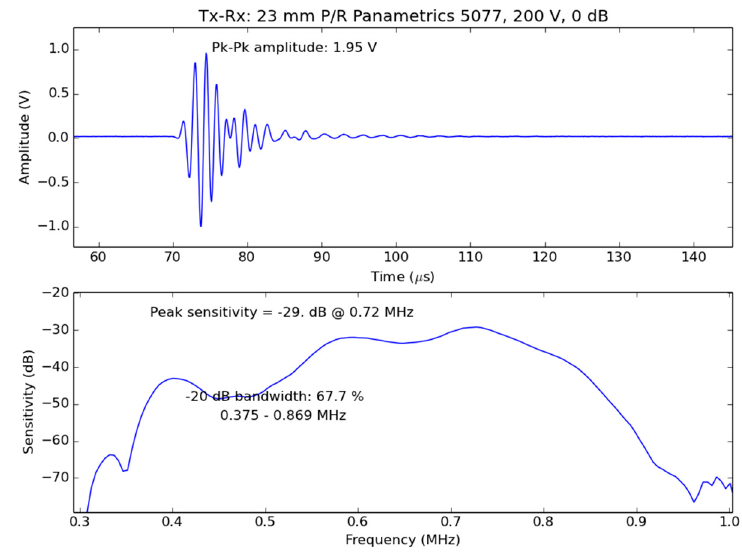
Figure 9. Response of the Tx-Rx pair for Vitis vinifera leaves in through transmission. Upper figure: the time domain response. Lower figure: sensitivity band.